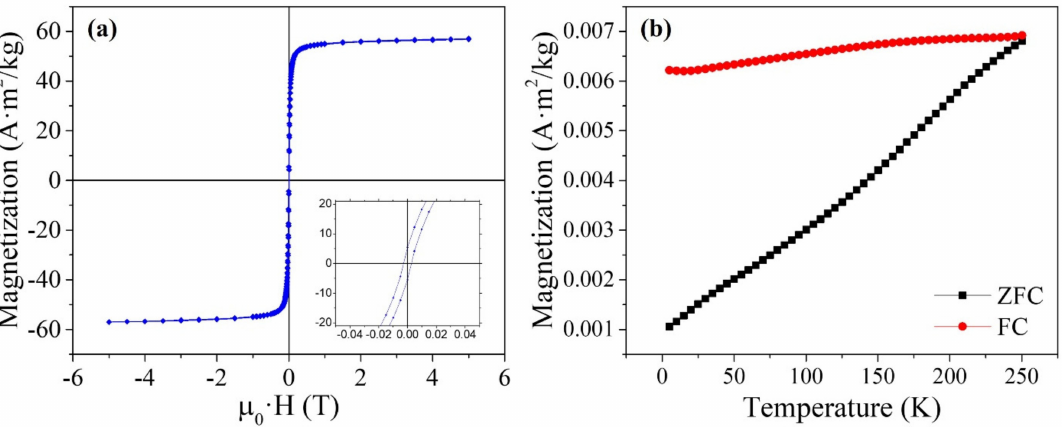
Figure 6. ( a ) Hysteresis loop of a powdered sample of the MNCs at 300 K. Inset: magnification of the curve at low fields. ( b ) ZFC-FC curves under a field of 2.5